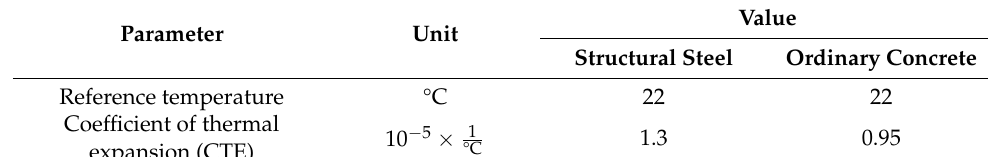
Table 3. Thermal properties of the materials used in the current study.